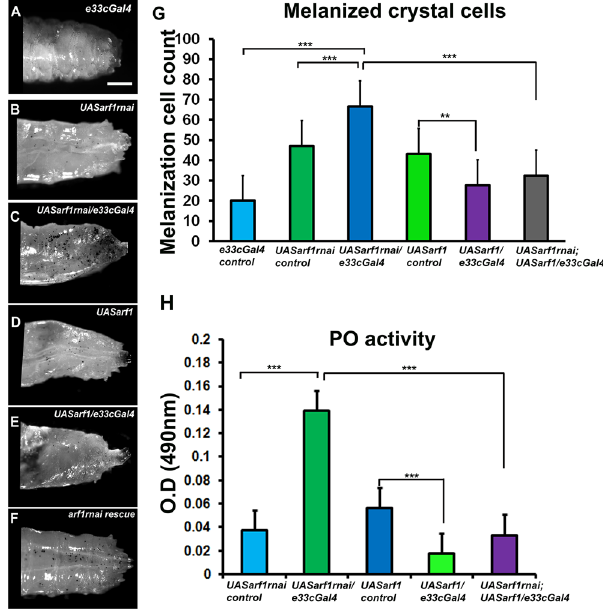
Figure 1. ARF1 regulates crystal cell- mediated melanization and phenoloxidase activity. ( A – F ) Photomicrographs showing posterior region of third instar larvae of specific genotypes ( A ) e33cGal4 ( B ) UAS arf1rnai ( C ) UAS arf1rnai / e33cGal4 ( D ) UAS arf1 ( E ) UAS arf1 / e33cGal4 ( F ) UAS arf1rnai / UASarf1rnai ; UAS arf1 / e33cGal4 that were heated at 60 °C for 10 min to visualize the melanization response. ( G ) Melanized crystal cells were quantified and represented graphically. ( H ) Graph representing phenoloxidase activity in the hemolymph of the indicated genotypes (detected as absorbance at 490 nm) after conversion of L-3, 4-dihydroxyphenylalanine. Scale Bar: ( A – F ) 100 μ m. Number of larvae analyzed per genotype (n = 10). Error bars show standard error of mean. P-value: ** and *** indicate P < 0.01 and P < 0.001